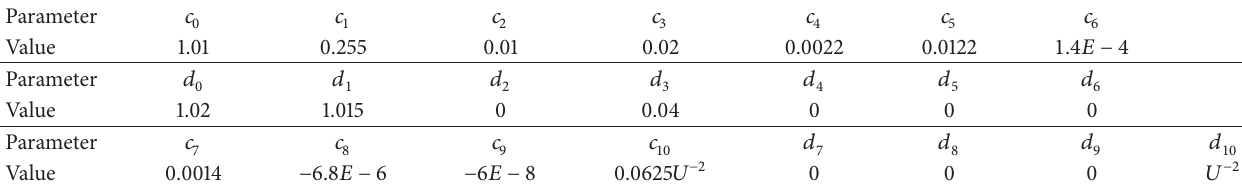
Table 3: Parameter values in system (8).